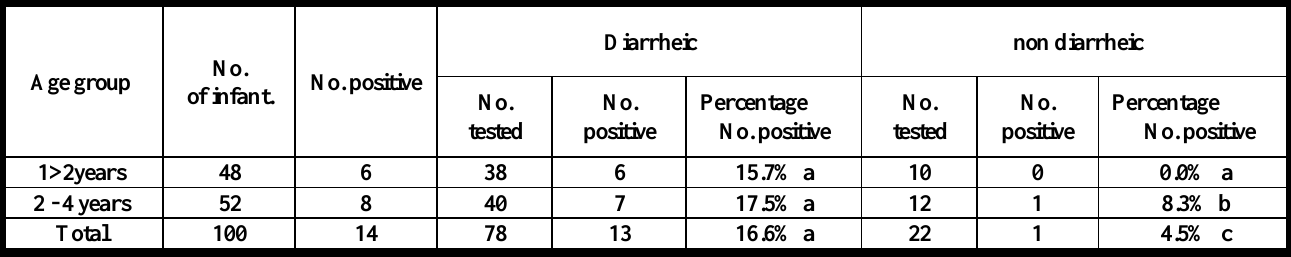
Table ( 2 ) Age wise prevalence of cryptosporidiosis in diarrheic and non diarrheic infants .